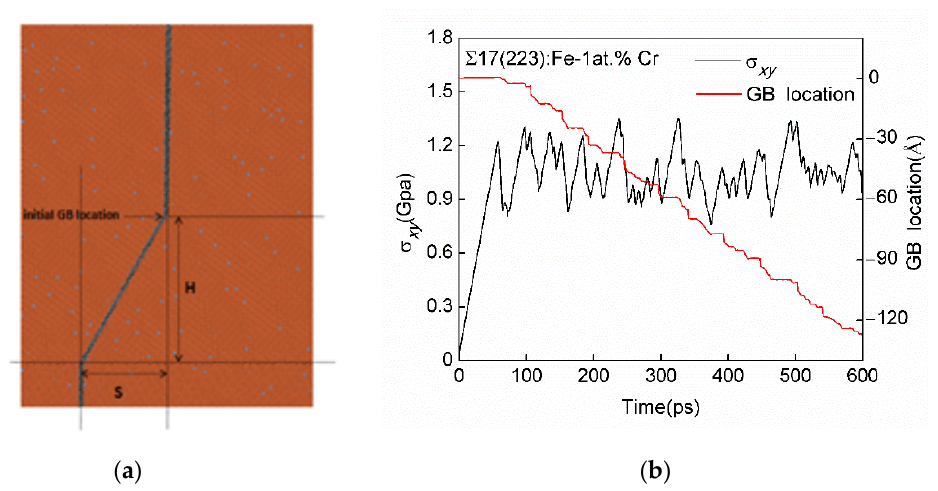
Figure 2. ( a ) MD snapshot at about 450 ps and ( b ) shear stress (σ xy )-time plot and GB location-time plot for the ∑17(223) GB in the Fe -1 at.% Cr alloy.